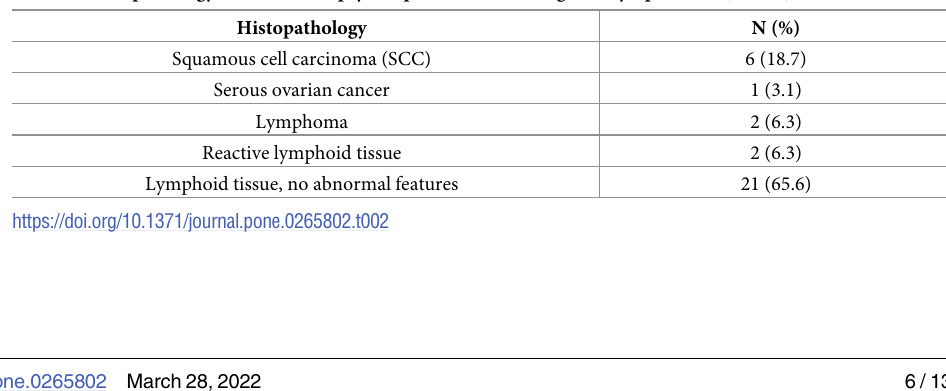
Table 2. Histopathology of the core biopsy samples or removed inguinal lymph nodes (N =